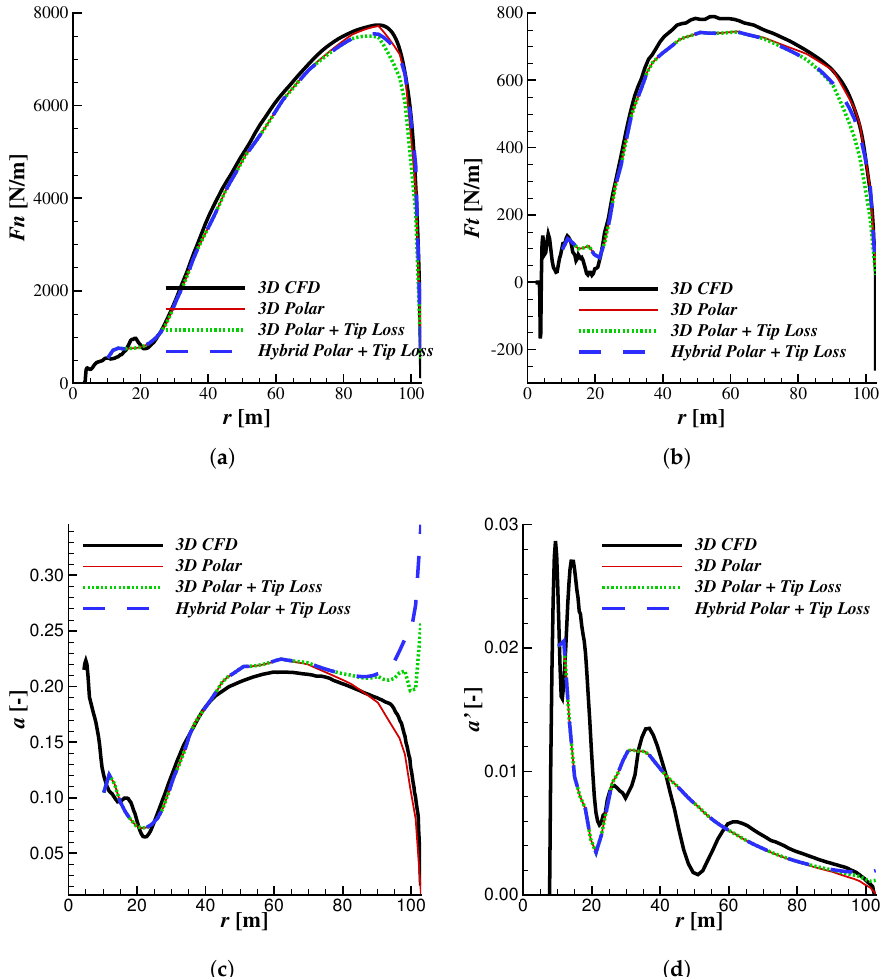
Figure 11. Tip loss model influence on the 3D polar datasets; ( a ) normal force, ( b ) tangential force, ( c ) axial induction, ( d ) tangential